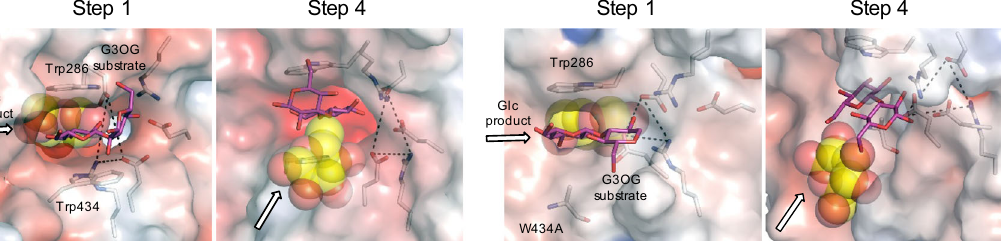
Fig. 9 | Mechanistic view of the catalytic function of HvExoI, a family GH3 enzyme. a HvExoI uses the retaining catalytic mechanism, where nucleophile Asp285(magenta)and acid/base catalystGlu491(green)playkey rolesinsubstrate hydrolysis 1 – 3 . b Reaction kinetics indicates the formation of Michaelis complexes (E-S and E~S), and enzyme-product complexes before (E~P1~Glc) and following the fi rst Glcegress (E~P1), and after hydrolysisof P1 (E~Glc) 1,2 . S and P1 are trimericand dimeric molecules, respectively. First-order rate constants are shown. Entrapped Glc product from E~Glc is displaced after a new substrate is attached. The hydro- lytic cycle with a (1,3)-linked substrate is repeated until it is hydrolysed to Glc (indicated by vertical and horizontal lines). c Simpli fi ed mechanism of Glc dis- placement with a disaccharide 22 . After thedisaccharide(empty blue and fi lledgrey